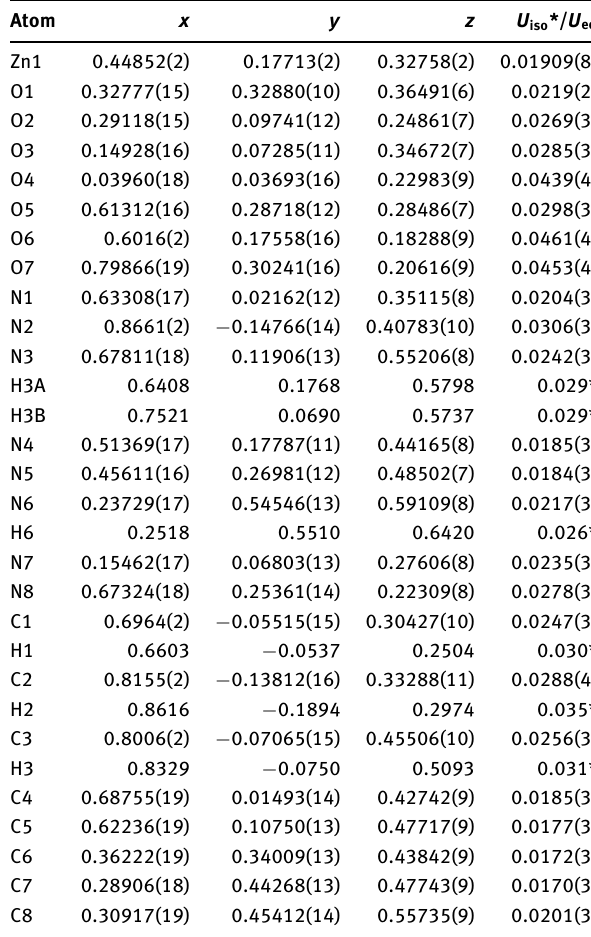
Table 2: Fractional atomic coordinates and isotropic or equivalent isotropic displacement parameters (Å 2